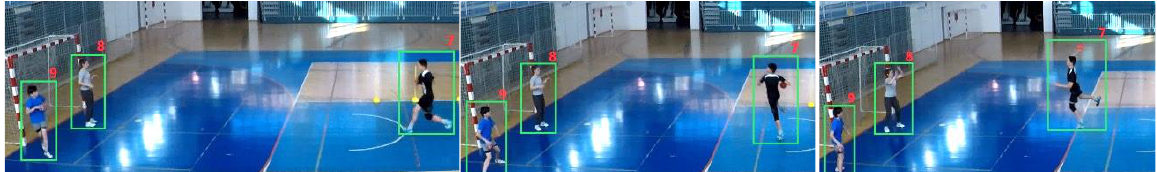
Figure 6. Example of tracking players with the identifications 7, 8 and 9 during three consecutive frames.